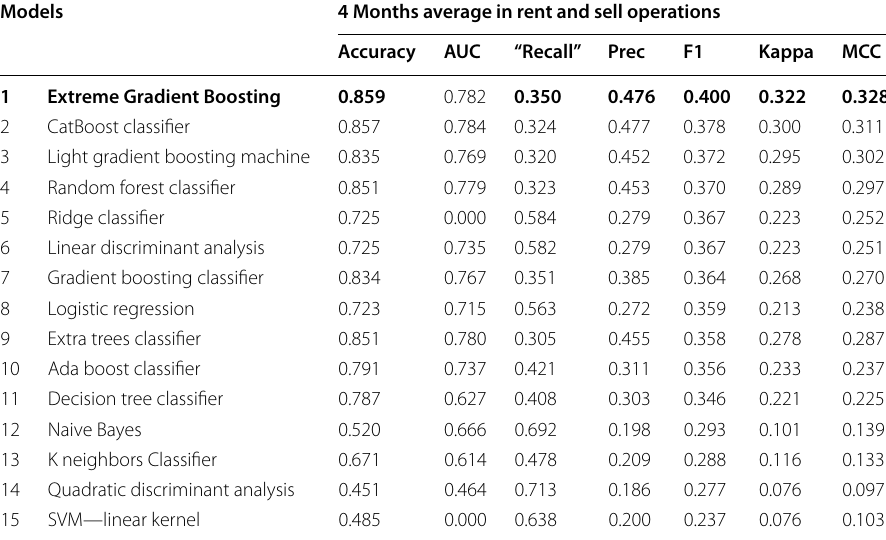
Bold values indicate the most consistent machine learning algorithm